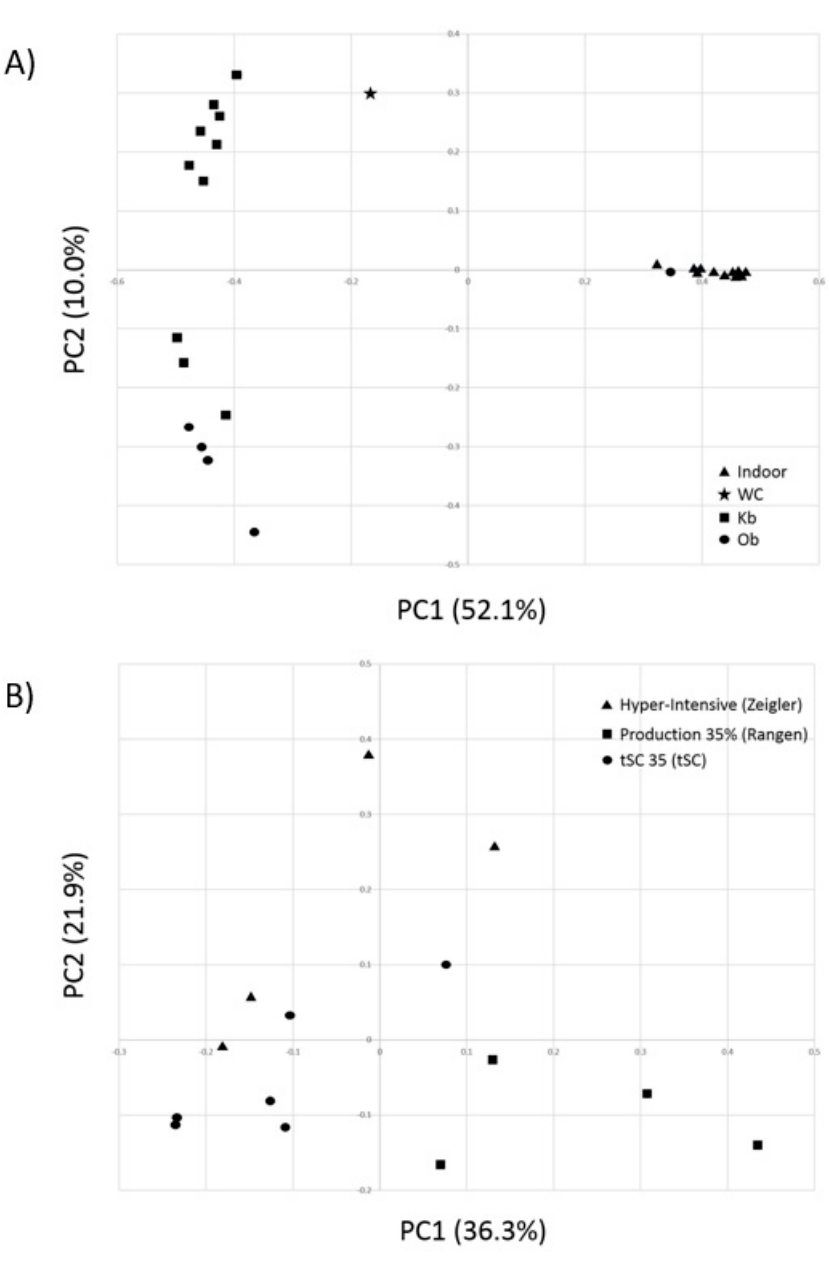
Figure 2. Comparison of intestinal bacterial communities from whiteleg shrimp using Principle Coordinate Analysis (PCoA). ( A ) Comparative analysis between shrimps raised under two different production systems and from one wild population. ( B ) Comparison amongst samples from white-leg shrimp raised in an indoor system under three different diets. The x and y axes correspond to Principal Components 1 (PC1) and 2 (PC2), which explained the highest level of variation. Table 4. Alpha diversity indices and coverage from gut bacterial communities of whiteleg shrimp raised under two different production